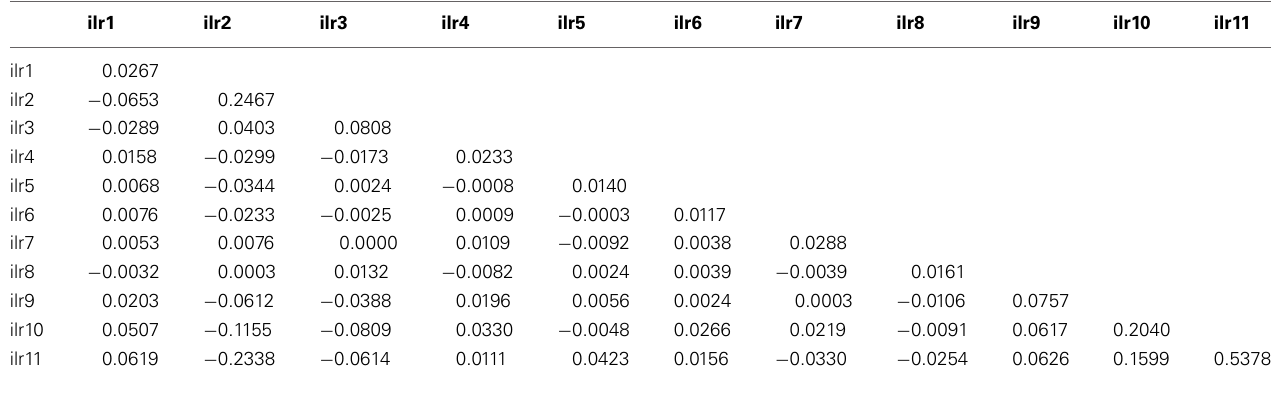
Table 4 | Covariance matrix (excluding outliers) of TN specimens of mango observations in the Brazilian data set used to compute the Mahalanobis